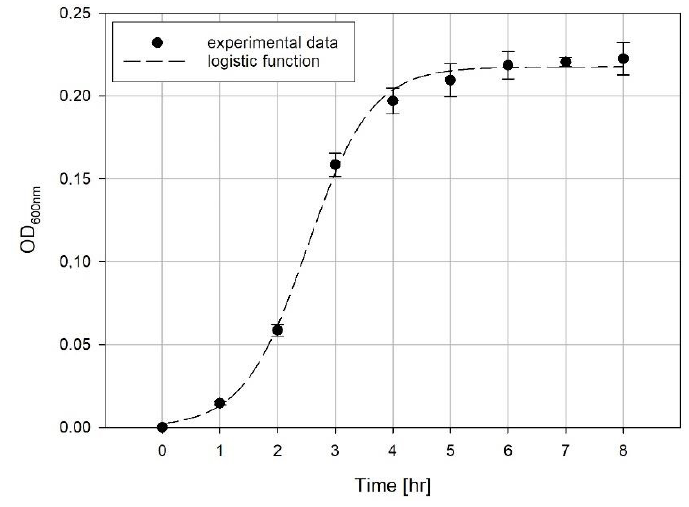
Figure 2. Example of the growth experimental data and model growth curve.